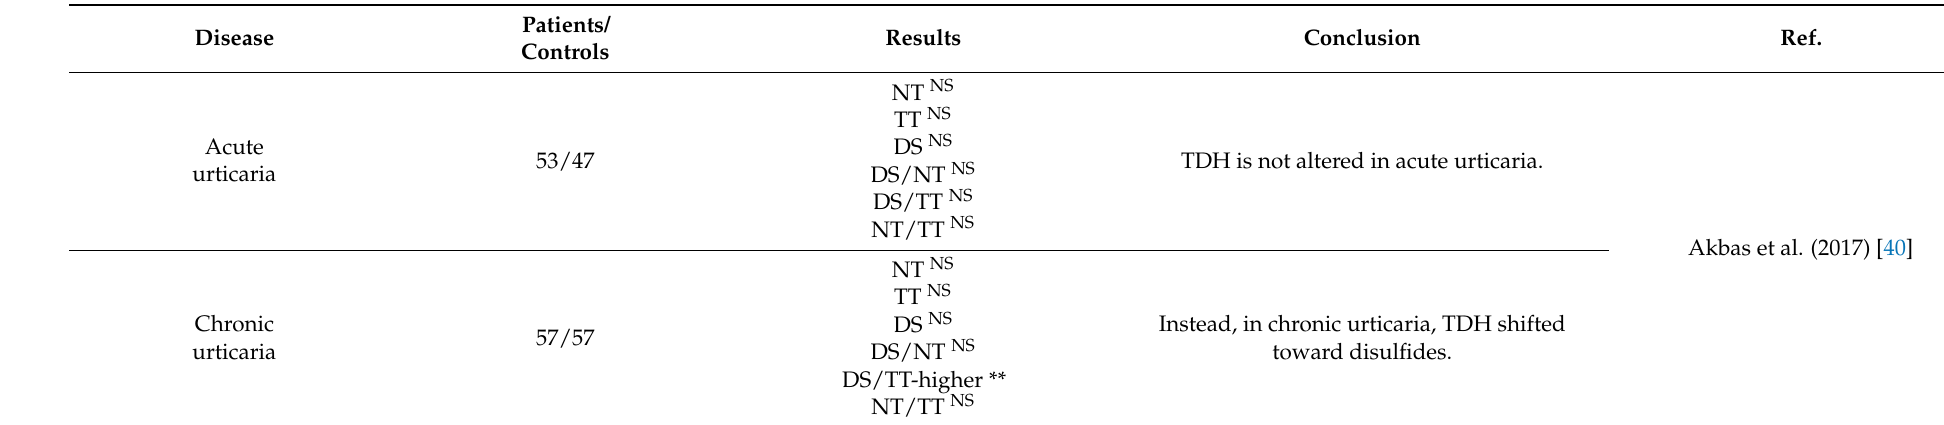
Table 2. Data on TDH parameters in allergic skin